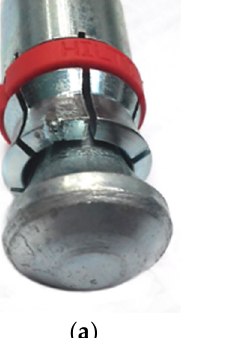
Figure 12. Self-undercut anchor: ( a ) before installation; ( b ) after use.